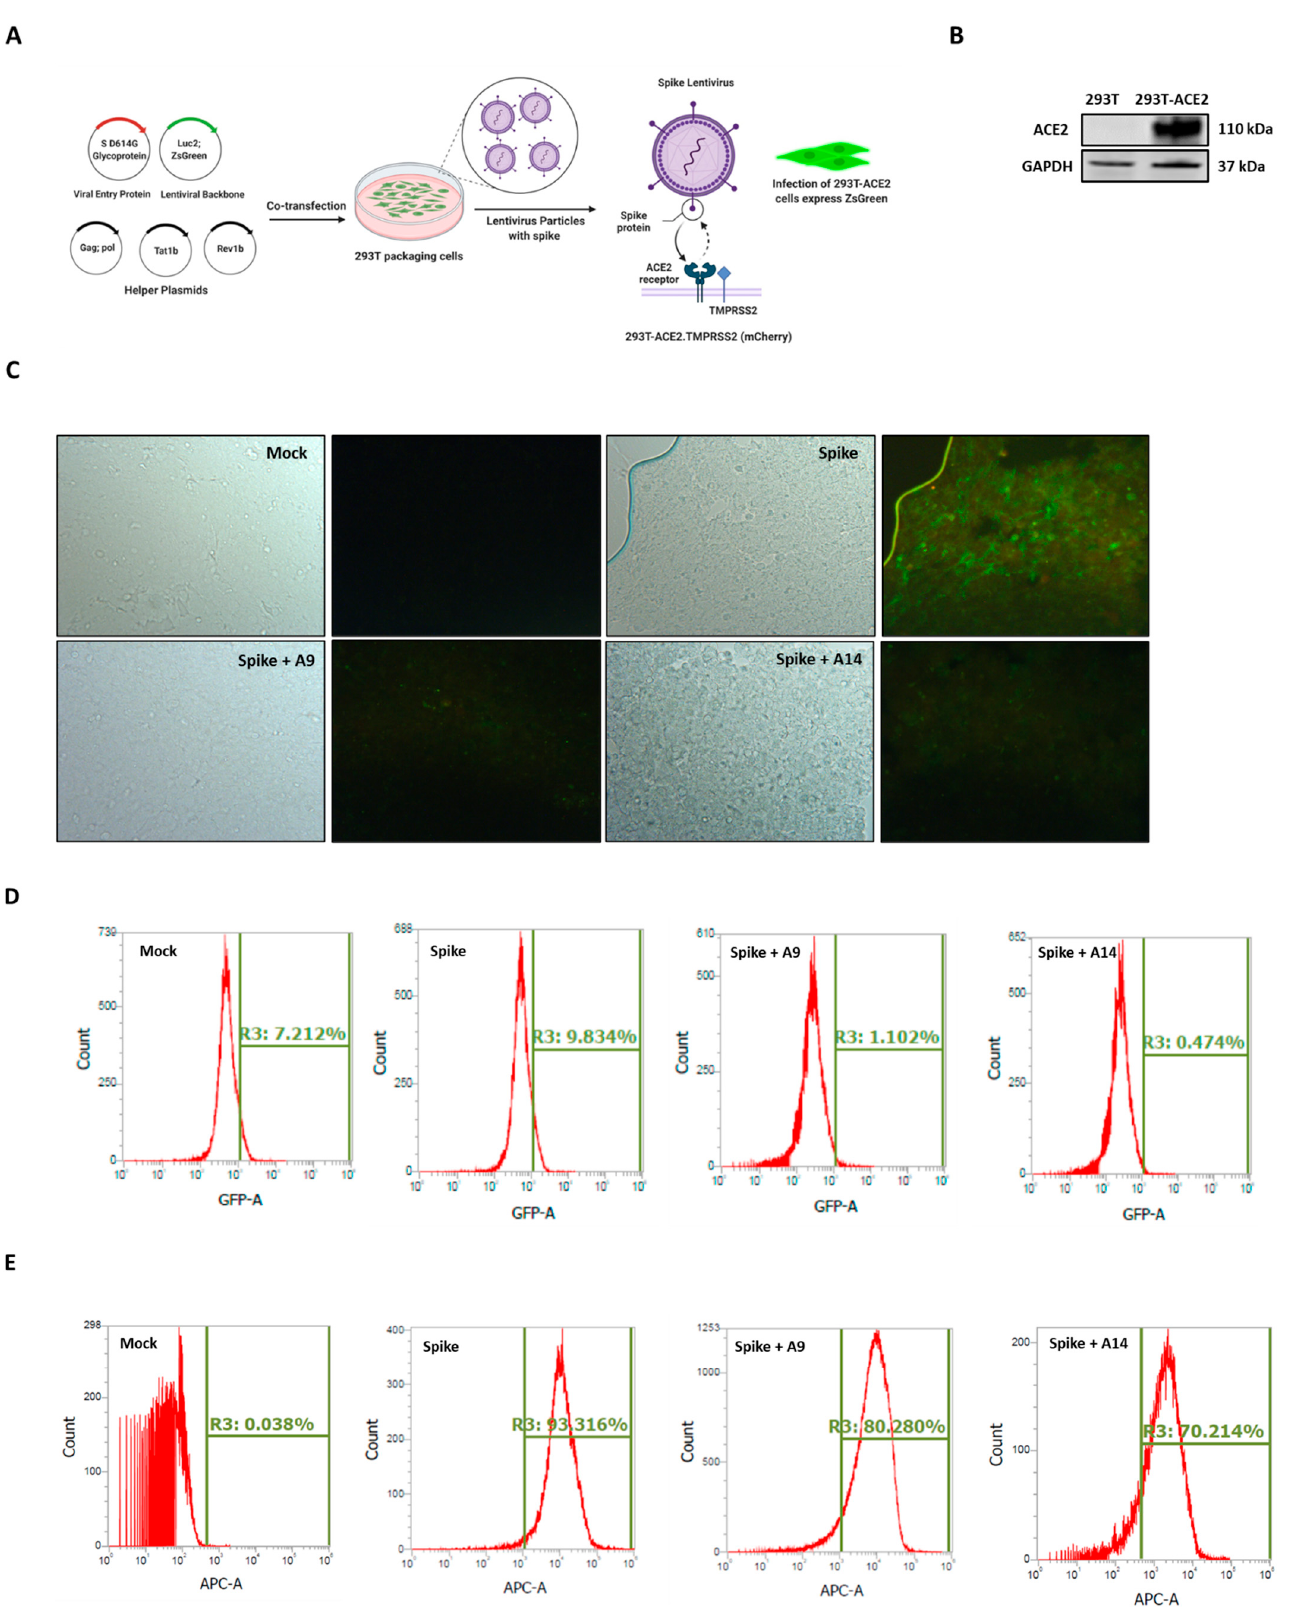
Figure 7. Impact of peptides A9 and A14 on SARS-CoV-2 Spike-pseudotyped Lentiviral Particles. Lentiviral pseudotyping schematic showing the use of ( A ) 293T cells as packaging cells for produc- ing lentivirus particles using Viral Entry Protein (S D614G Glycoprotein), Lentiviral Backbone